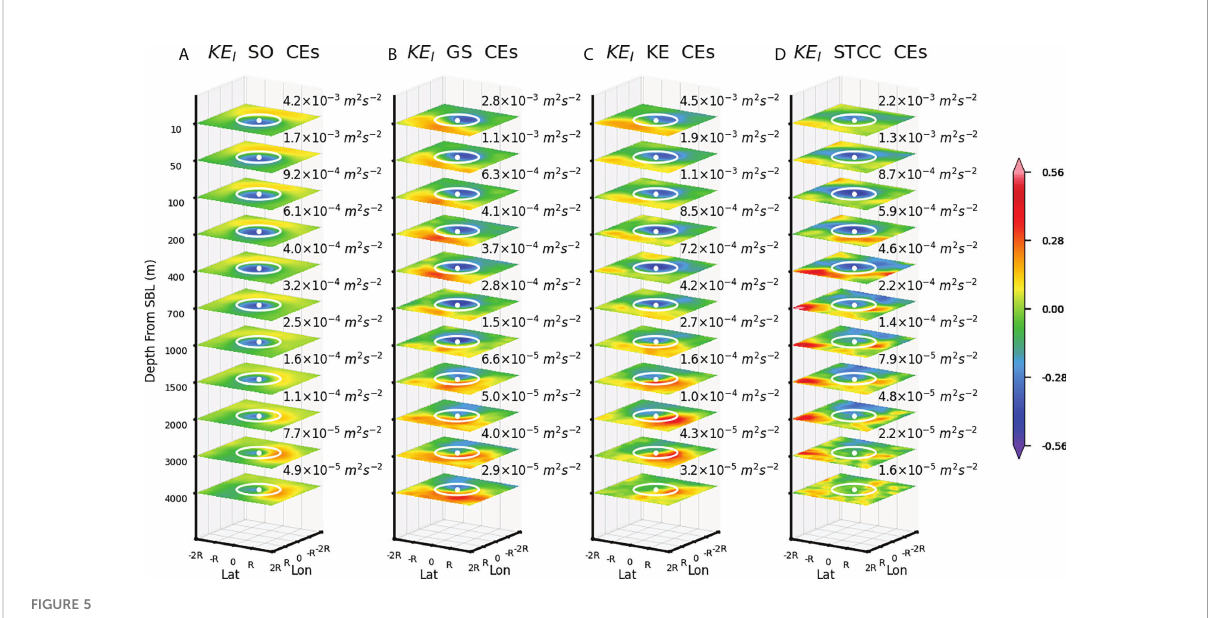
FIGURE 5 Same as Figure 4 but for